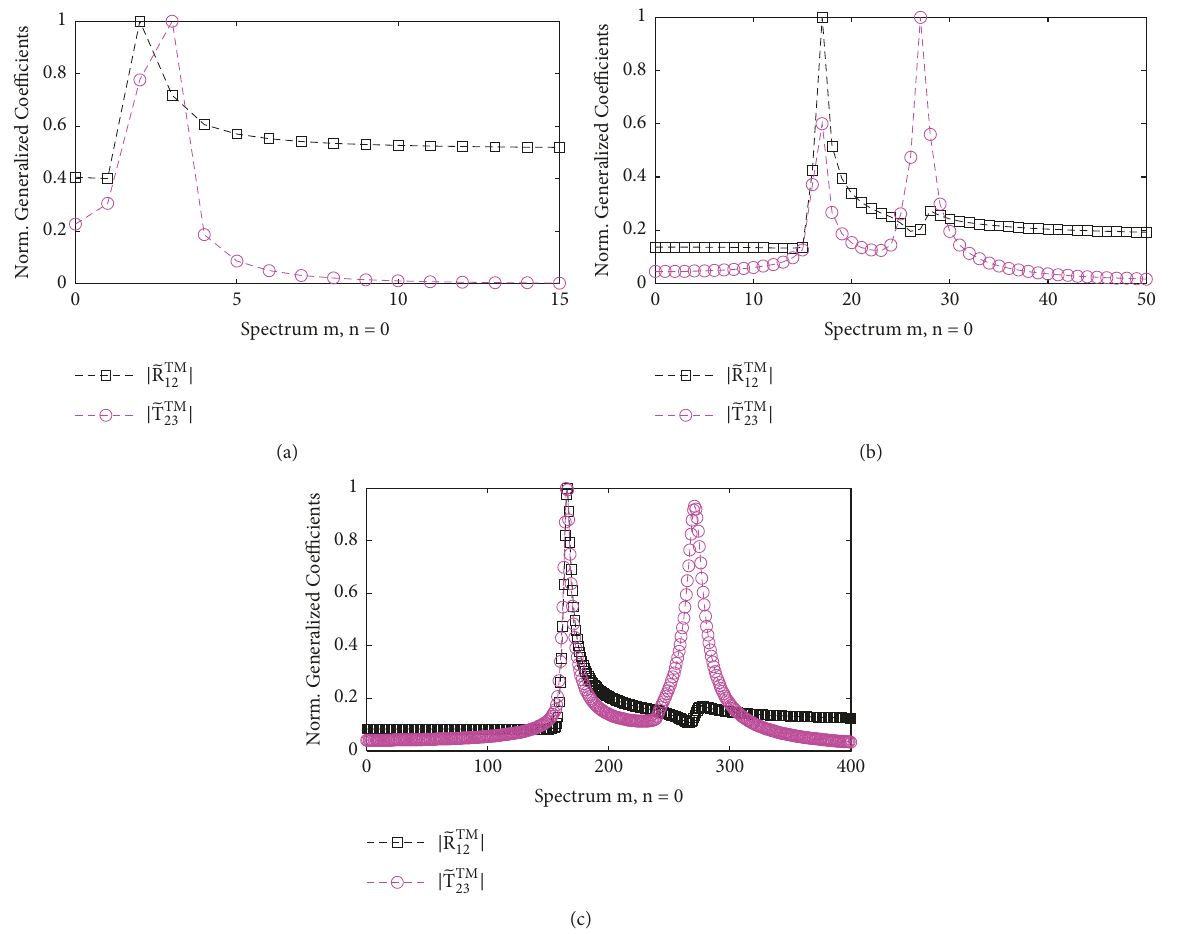
|̃𝑅 𝑇𝑀 | and |̃𝑇 𝑇𝑀 | in 𝑚 , with 𝑛 = 0 , for (a) Δ 21 23